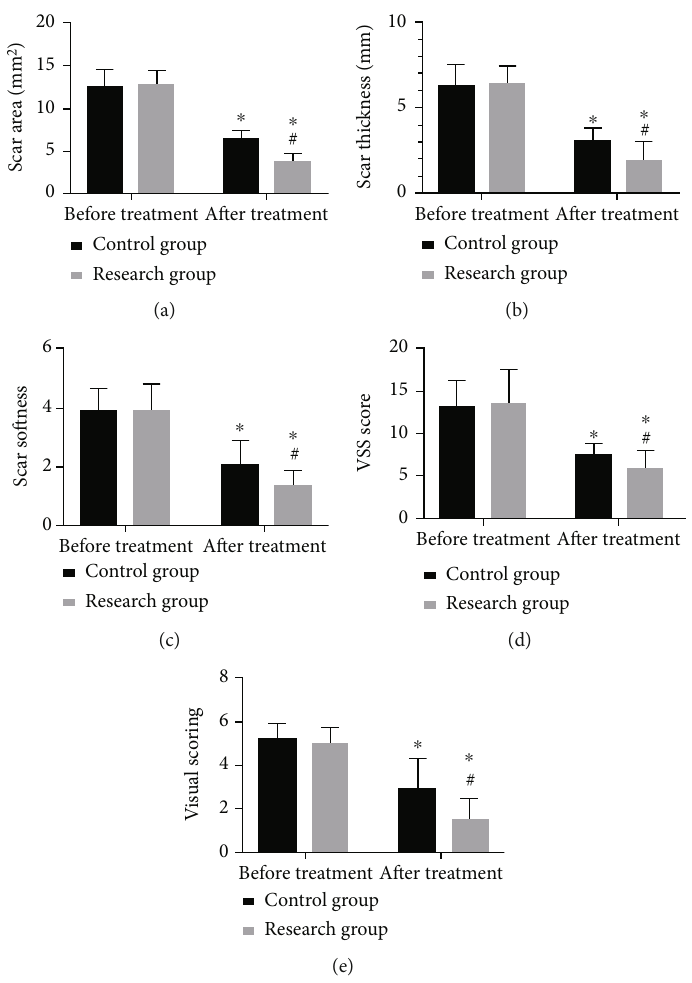
Figure 1: Comparison of scar repair. (a) Scar area before and after treatment. (b) Scar thickness before and after treatment. (c) Scar softness before and after treatment. (d) VSS score before and after treatment. (e) Visual score before and after treatment. ∗ Di ff erence vs. the situation before treatment. # Di ff erence vs. the control group. VSS: Vancouver scar scale.